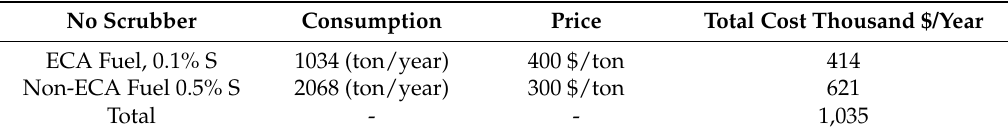
Table 6. Yearly running cost in USD (United States dollar) using low-sulfur fuel without